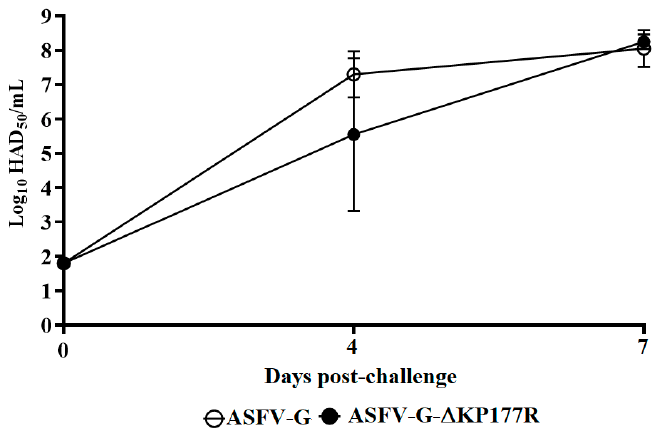
Figure 5. Viremia titers detected in pigs IM inoculated with 10 2 HAD 50 of either ASFV-G- ∆ KP177R (filled symbols) or ASFV-G (empty symbols). Each symbol represents the average of animal titers in each of the groups. Sensitivity of virus detection: >log 10 1.8 TCID 50 /ml. Significant differences in viremia values between both groups of pigs were found at day four post-infection using the Holm-Sidak method ( α = 0.05) without assuming a consistent standard deviation. All calculations were conducted on the software GraphPad Prism version 8.